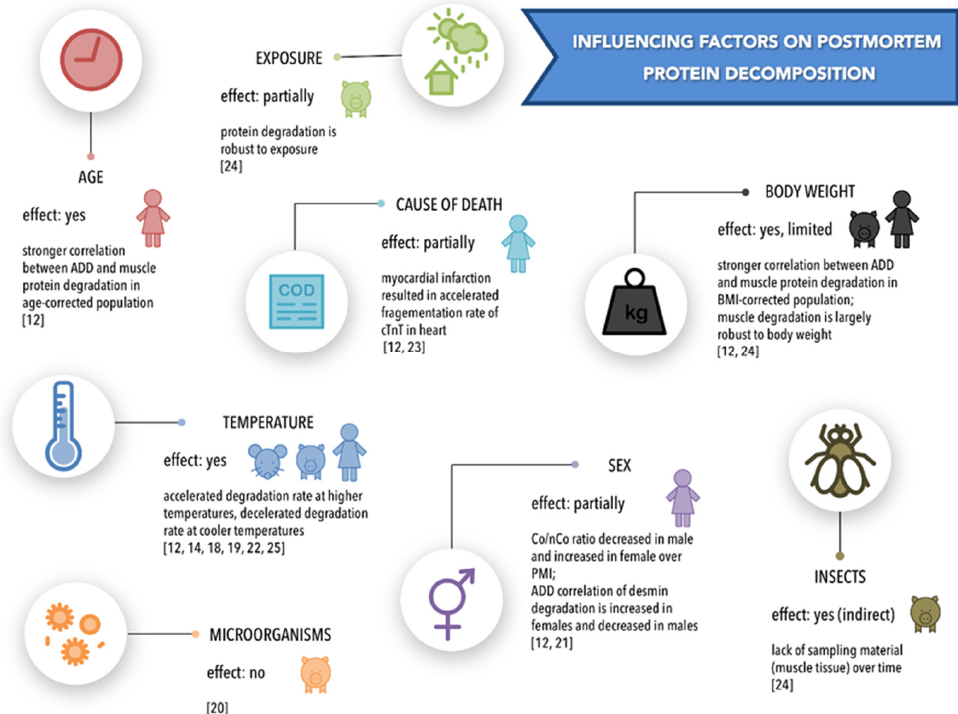
Figure 4. Effects of influencing